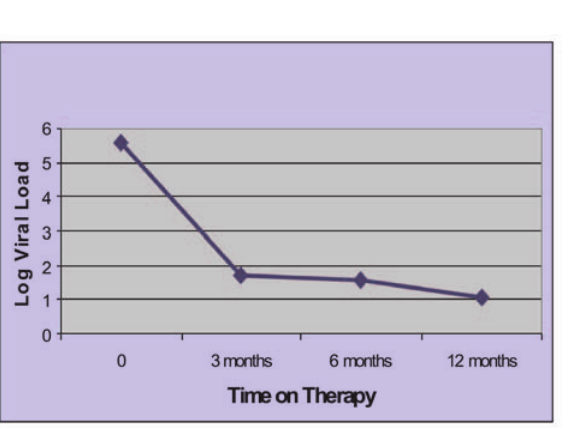
Fig. 2. Mean log viral load during first year of therapy.